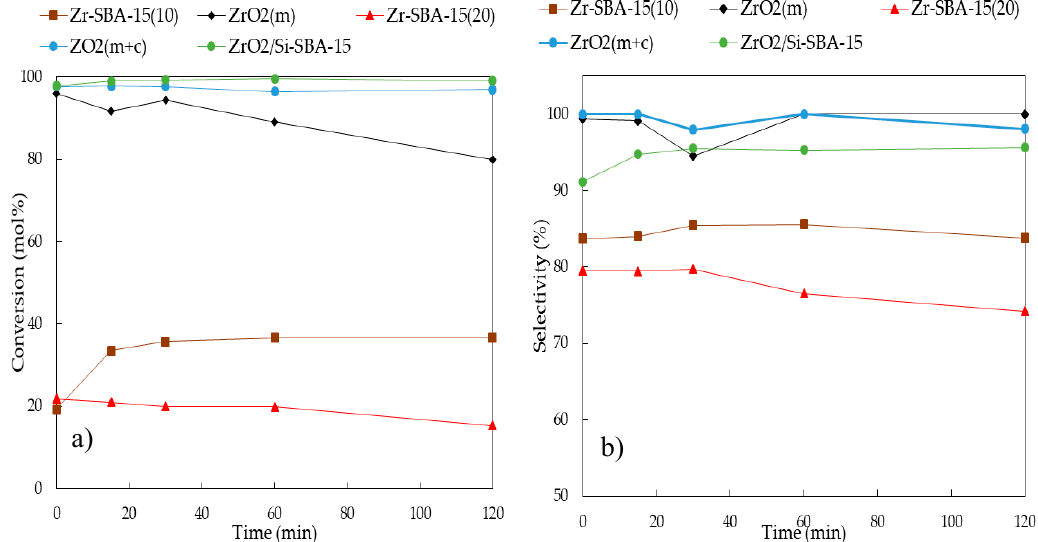
Figure 3. Catalytic activity of the Zr-based materials evaluated in the hydrogenation of ML to GVL expressed as: ( a ) conversion and ( b ) selectivity.